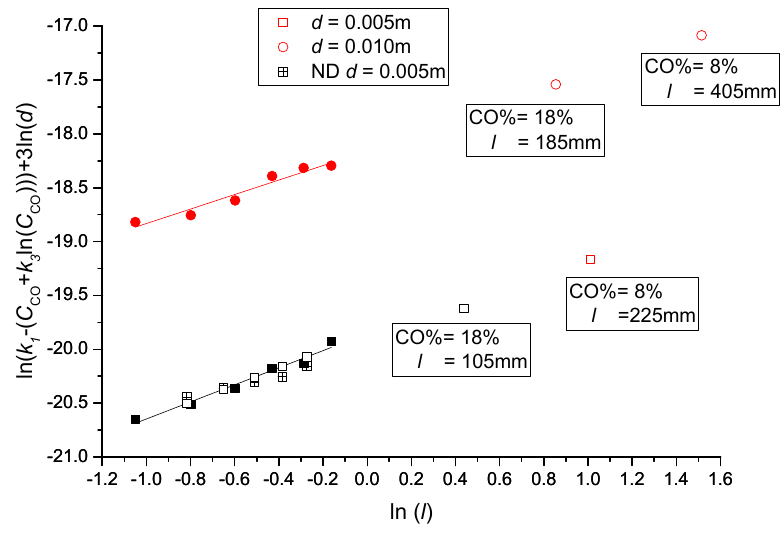
Figure 11. Fitting line of the CO